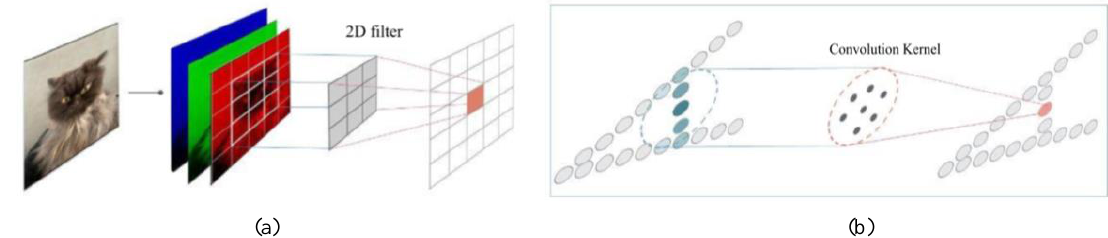
Figure 3. The simplified 2D illustration of convolution. Left: the use of a 2D filter on an input image. Right: using a 3D rigid convolution kernel on the input point cloud, where the weights for neighbouring points are proportional to the spatial distribution of the centroid point in Euclidean space, shown in the gradient colours in the neighbour points of the